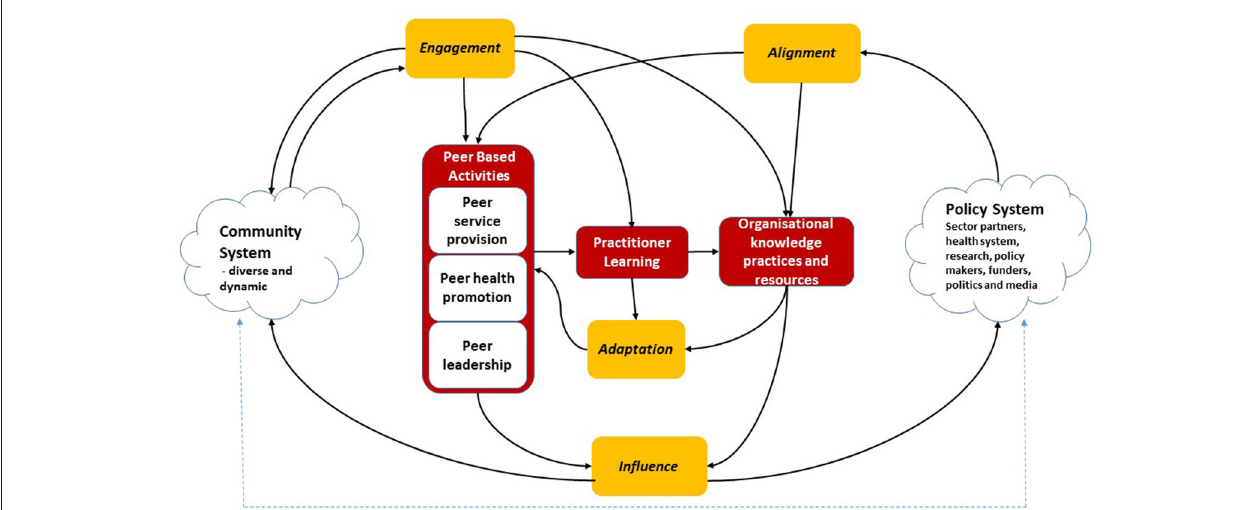
FIGURE 1 | W3 Framework Image. Reprinted from Brown and Reeders (45) under a CC BY license, with permission from (Australian Research Centre in Sex Health and Society La Trobe University), original copyright (2016).